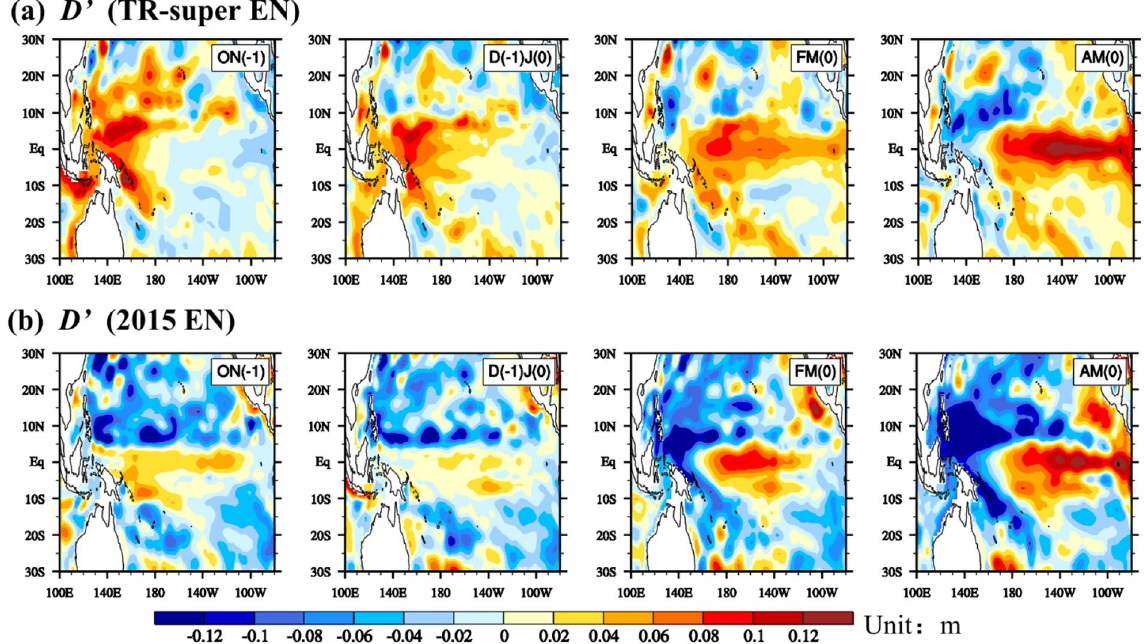
Figure 2. The evolution of the sea surface height anomaly ( SSH ′ ; a proxy of D ′ ) from GODAS for ON[ − 1], D[ − 1]J[0], FM[0] and AM[0], derived from ( a ) the composite of TR-super EN and ( b ) 2015EN. Here a linear D ′− SSH ′ relationship was applied. All plots were generated by the NCAR Command Language (NCL, version 6.2.1, [Software]. (2014). Boulder, Colorado: UCAR/NCAR/CISL/VETS. http://dx.doi.org/10.5065/